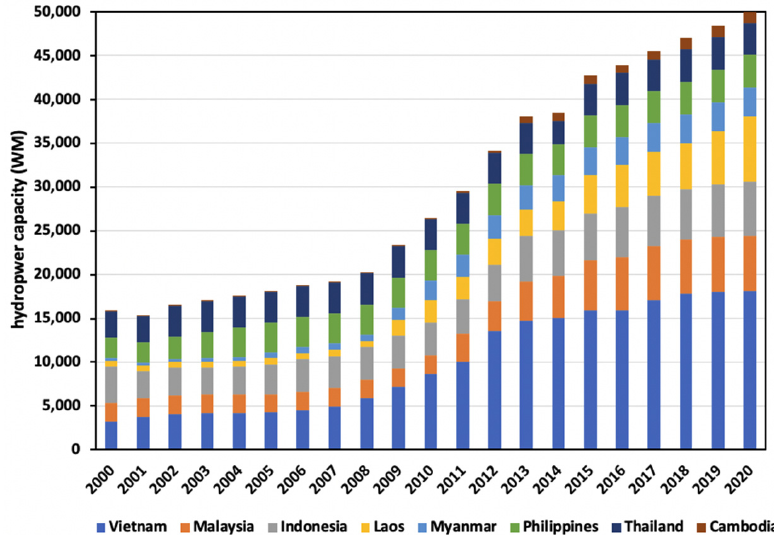
Figure 4. History of hydropower capacity in ASEAN